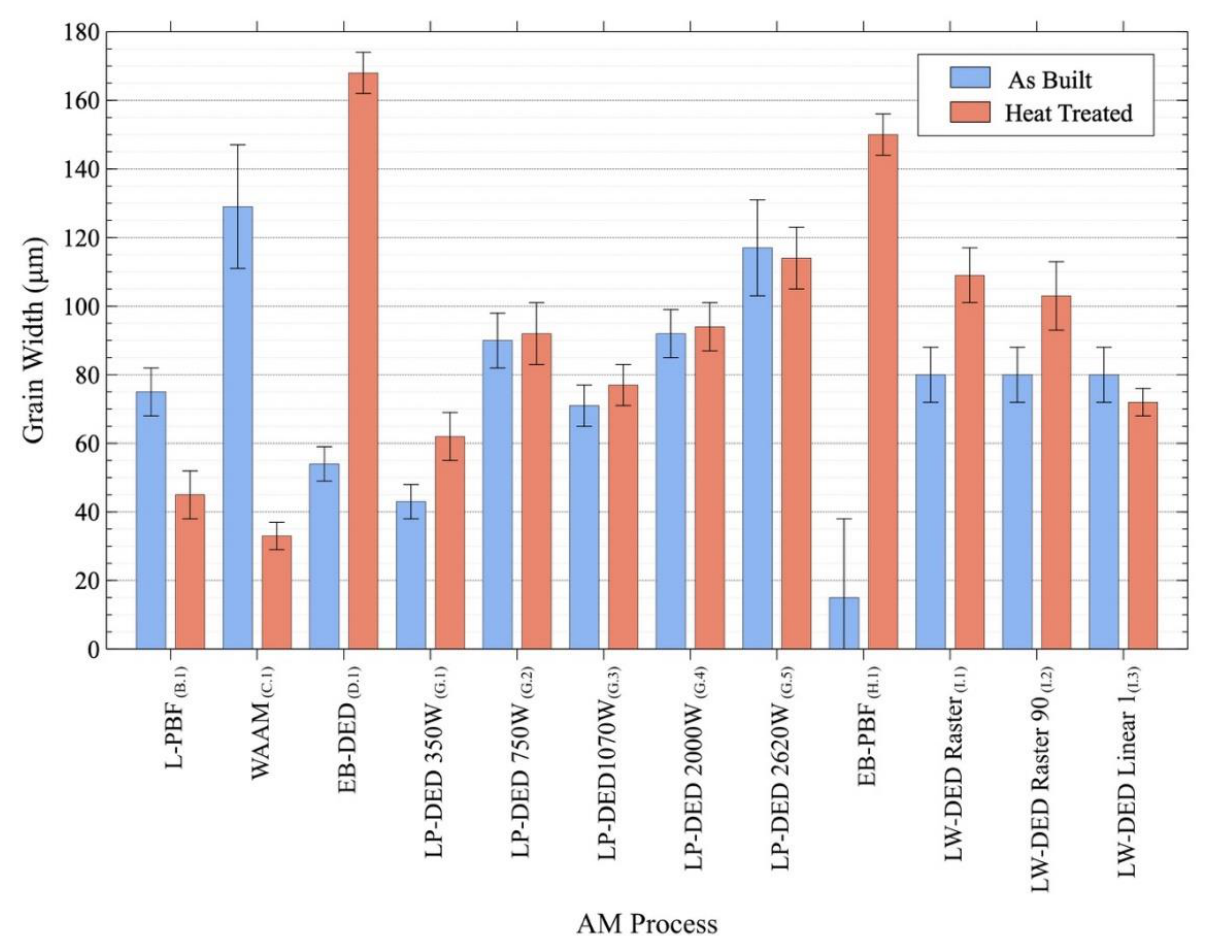
Figure 10. Direct comparison of AM process grain widths for as-built and heat-treated (stress relief, HIP, solution) components.